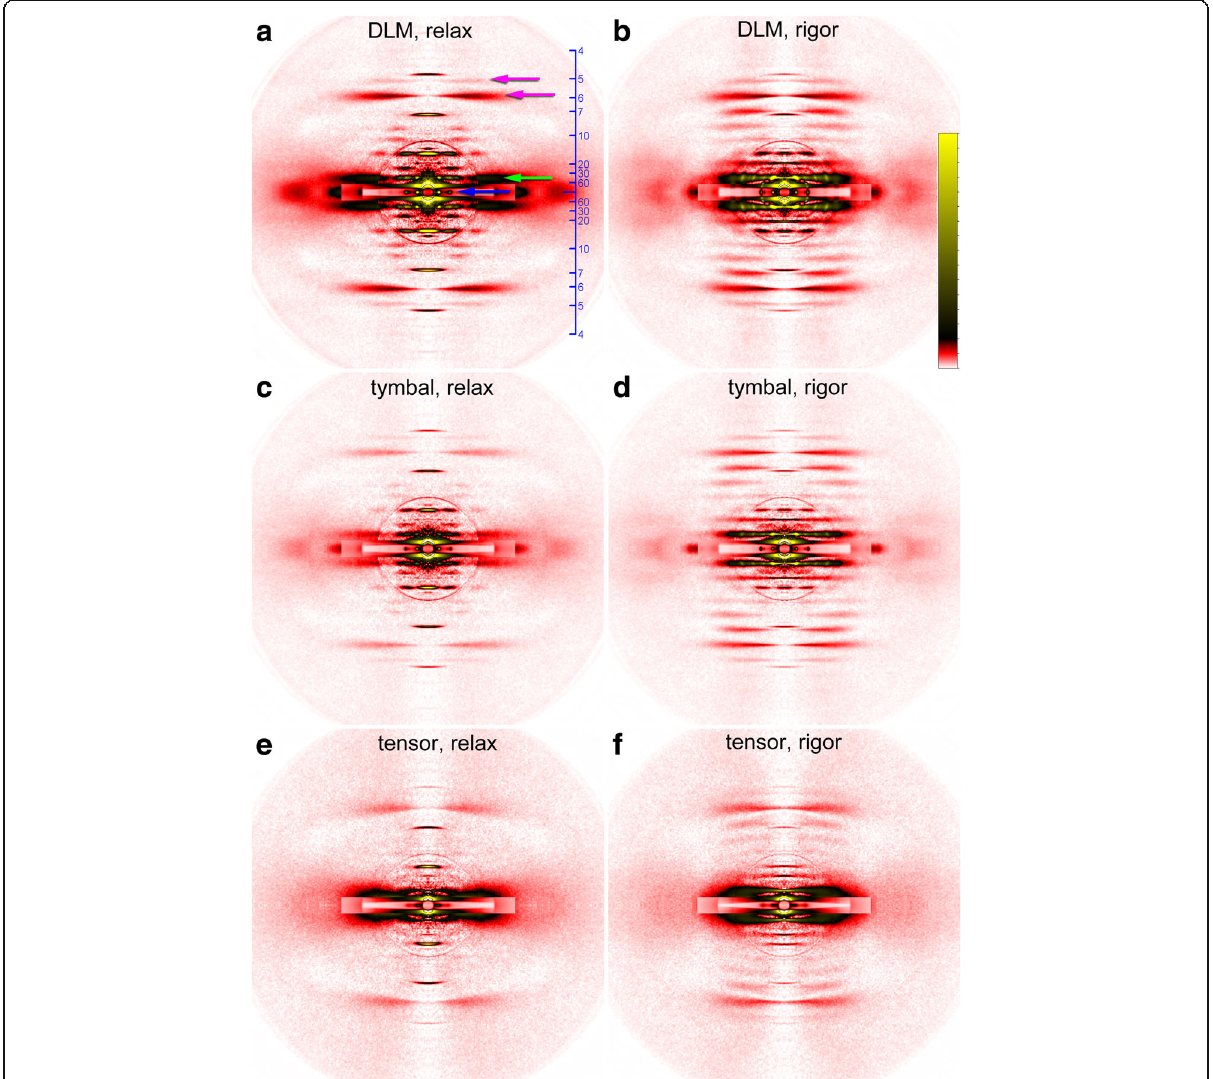
Fig. 3 X-ray diffraction patterns of the flight and tymbal muscles of Meimuna oparifera. ( a ) and ( b ), DLM; ( c ) and ( d ), tymbal muscle; ( e ) and ( f ), tensor muscle. a, c and e were recorded in the relaxed state, and b , d and f , rigor state. Blue arrow, equatorial reflections; green arrow, first myosin/actin layer line reflection, magenta arrows, actin layer line reflections. The scale on the right of A represents the d -spacing in nm. Note that in rigor, the actin layer lines are enhanced, and the first myosin/actin layer line is finely lattice-sampled in flight and tymbal muscles but not in